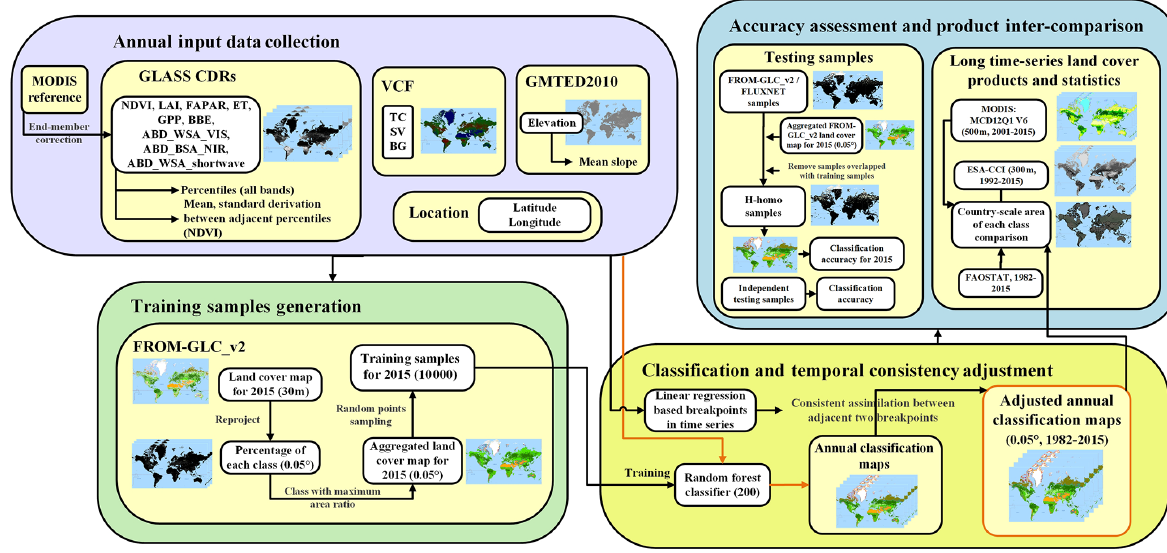
Figure 1. The framework for building GLASS-GLC (annual dynamics of global land cover) CDRs (climate data